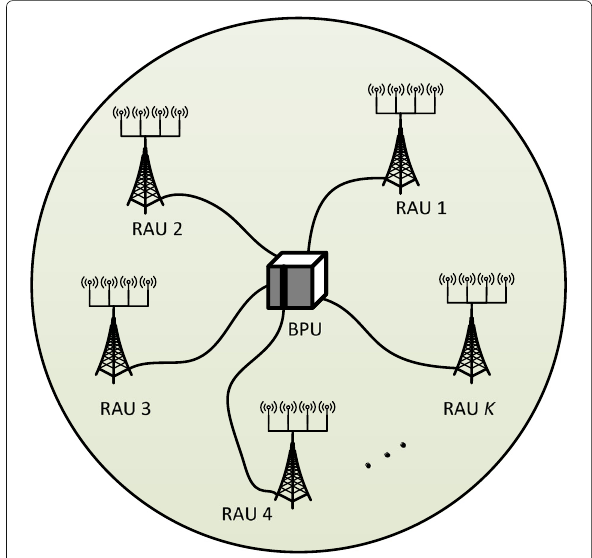
Fig. 2 Illustration of distributed antenna array